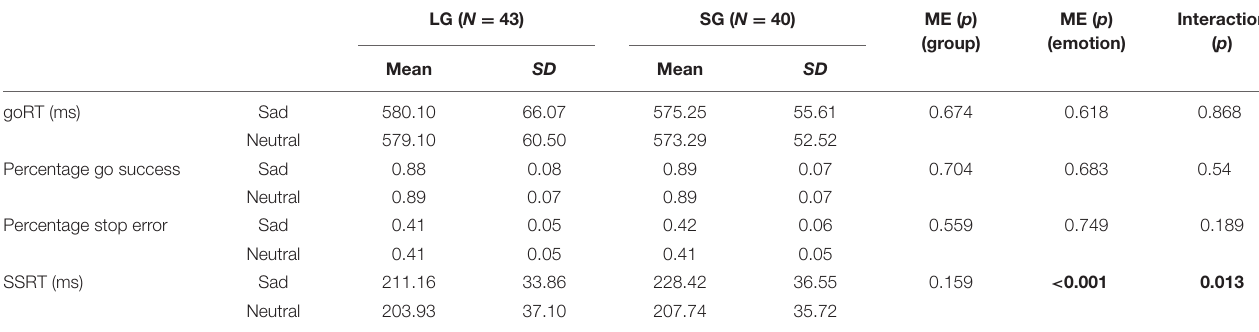
TABLE 1 | Behavioral performance on the emotional stop signal task (eSST) for LG and SG individuals.